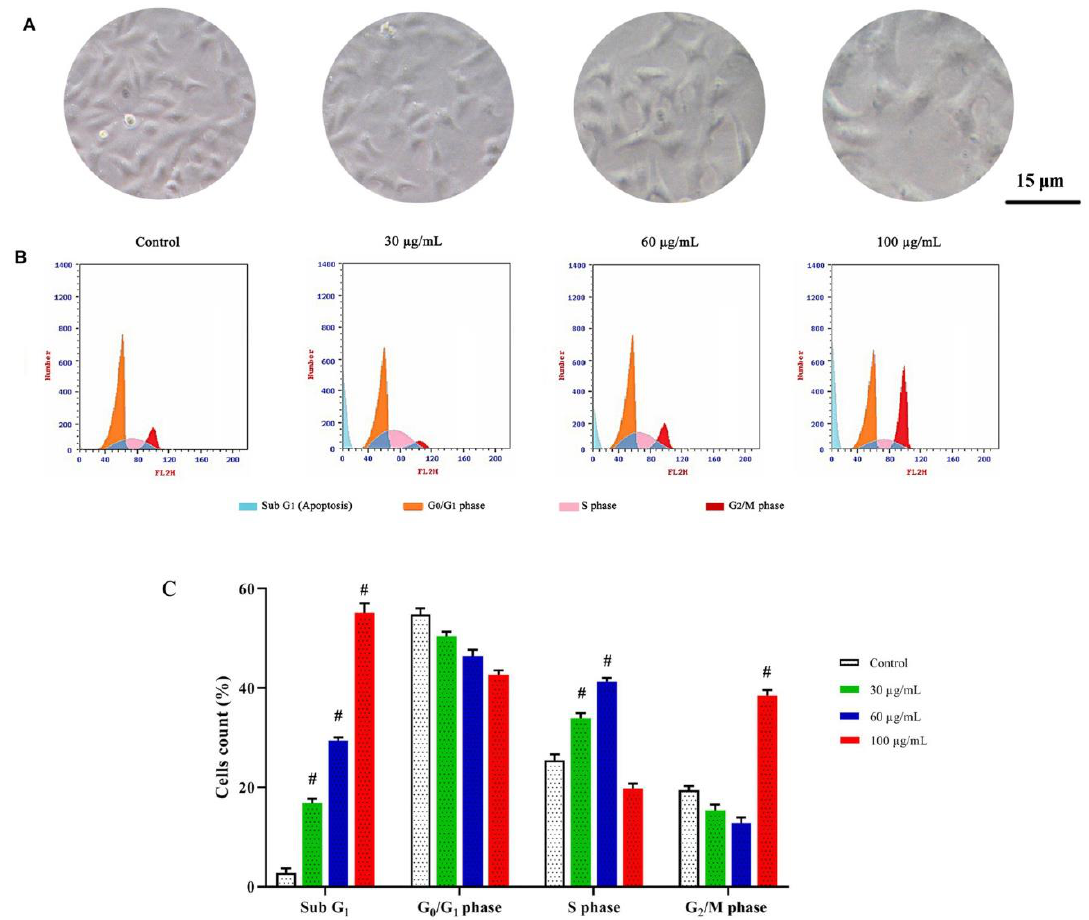
Figure 4. Effect of different M domestica hemolymph concentrations, 8 h post-curcumin injection ( A ), on the cell cycle distribution of treated and control MCF-7 cells. The cell cycle phases were analyzed according to DNA contents after propidium iodide (PI) labeling ( n = 3) ( B ). Data were illustrated as mean±SD; different letters show the significant difference ( p < 0.05) ( C ).